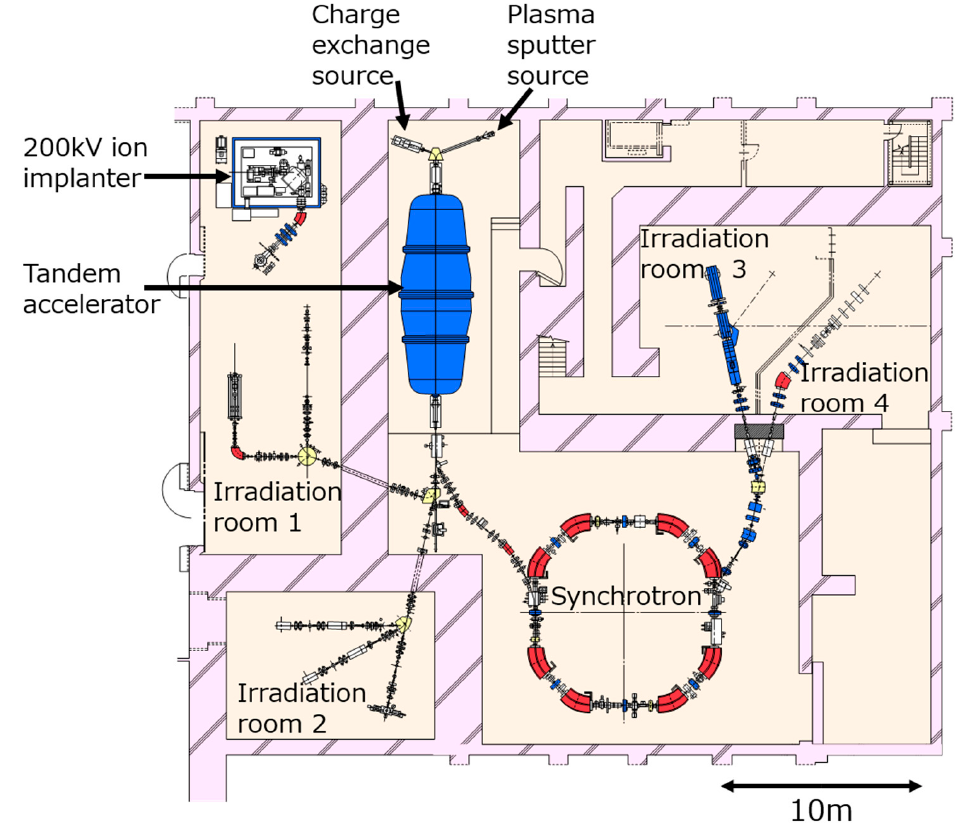
Figure 1. Layout of two ion sources, the tandem accelerator, the synchrotron, the ion-implanter, and their beam transport lines at WERC [1,2].